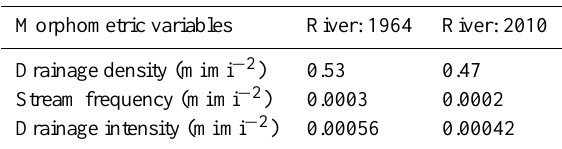
Table 7. Changes in other morphometric indices of Owo River Basin.